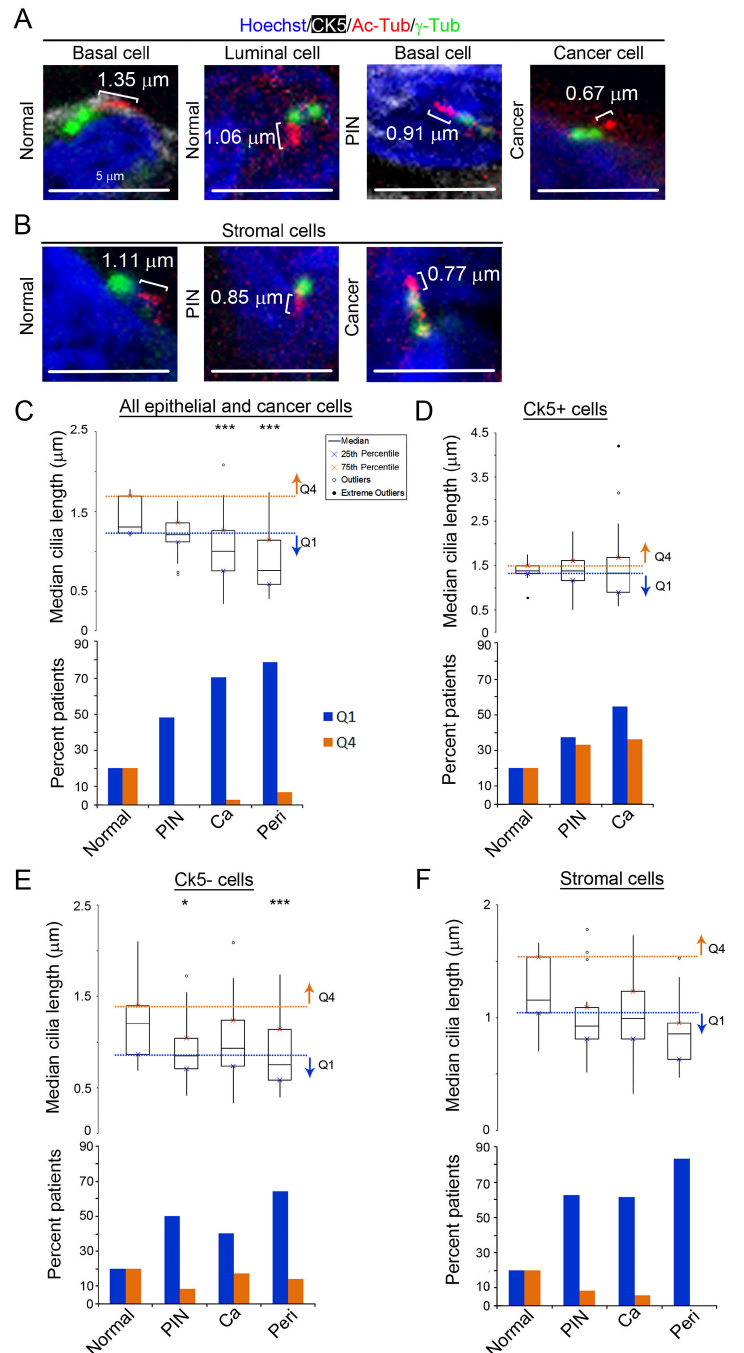
Figure 4. Ciliated prostate cancer and stromal cells have decreased axoneme lengths. (A and B) Primary cilia (Ac-Tub; red), centrosomes (γ-Tub; green), nuclei (Hoechst; blue), and cytokeratin 5 (CK5; white), are shown to illustrate representative ciliary lengths. Images were selected to represent the median length for normal and the 25 th percentile for PIN and cancer cells (note that many PIN and cancer cells have cilia shorter than those shown). Cilia lengths are given. (A) Normal basal cell, normal luminal cell, CK5+ basal cell in PIN, CK5-cancer cell and (B) stromal cell in normal, PIN, and cancer tissue. Boxplots of cilia lengths for (C, top) all epithelial, (D, top) CK5+, (E, top) CK5-and (F, top) stromal cells per patient for normal, PIN, cancer (Ca), and perineural invasion (Peri). Q4, Q1 are as in Figure 1. Statistics were performed using linear regression (* = p<0.05, *** = p<0.001) (C, D, E, and F, bottom). The percent of patients with abnormally long cilia (Q4; orange) or abnormally short cilia (Q1; blue).